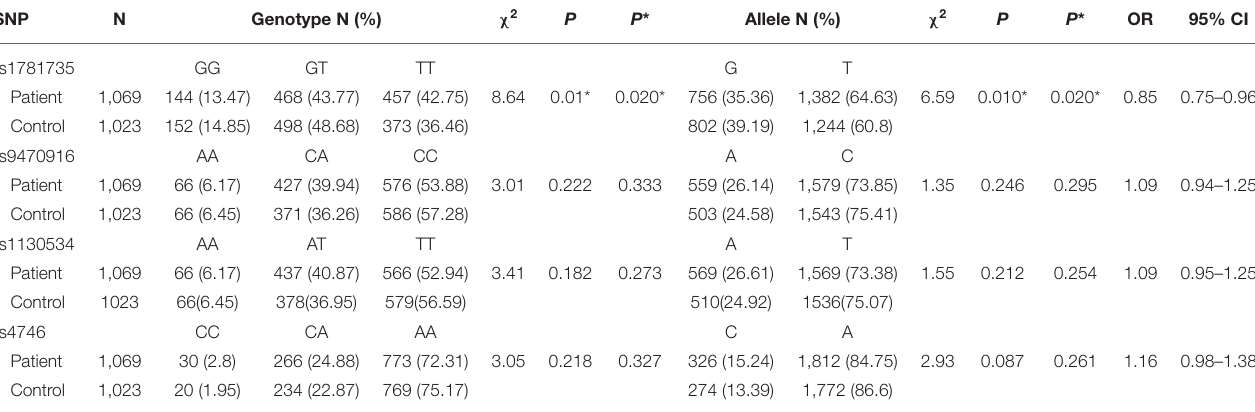
TABLE 1 | Genotype and allele distributions of glyoxalase 1 (Glo-1) polymorphisms in the